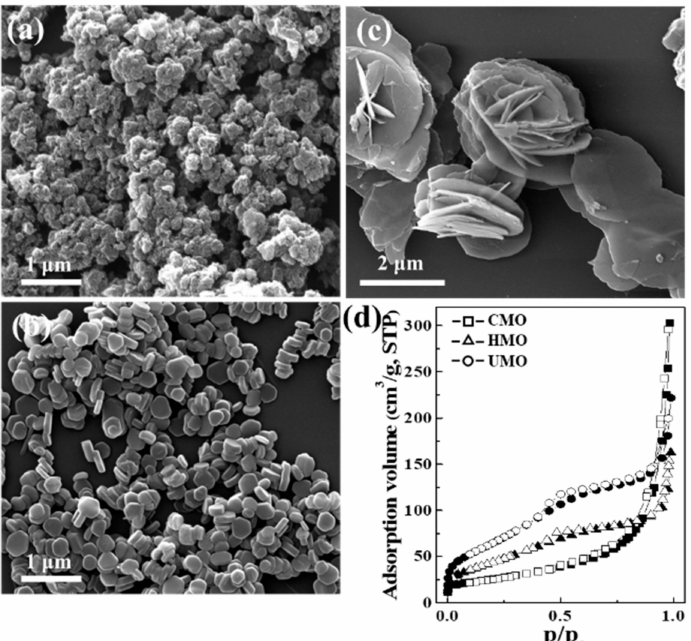
Figure 3. Scanning electron microscopy (SEM) images of ( a ) CHO, ( b ) HMO, and ( c ) UMO. CMO, HMO, and UMO are results of calcination of LDH that synthesized by coprecipitation, hydrother- mal, and urea-hydrolysis, and ( d ) N 2 adsorption-desorption isotherms for CMO, HMO, and UMO (adapted from [58] with the permission from Elsevier,